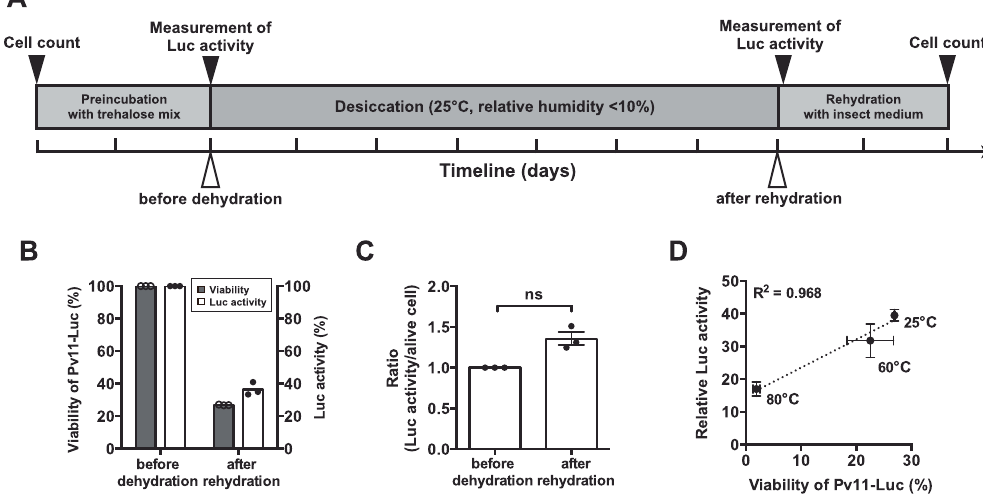
Figure 2. Viability and enzyme activity of Pv11 (Pv11-Luc) cells stably expressing luciferase. ( A) Schematic timeline represents the time point of each treatment (white arrowheads) and of the measurements (black arrowheads), respectively. Major tick intervals represent one day. The detailed procedures including preincubation, desiccation and rehydration are described in the previous study 30 . Pv11 cells are expected to be fully dehydrated about 30 h after the beginning of desiccation. Percentage of luminescence intensity of Luc and cell count was measured before the desiccation step (i.e., after pretreatment with 600 mM trehalose mixture containing both 10% IPL-41 and 1% FBS). Luminescence intensity caused by luciferase was measured 1 h after rehydration. Viability of Pv11-Luc cells was counted with the WST-8 assay. ( B) Viability of Pv11-Luc cells (bars in grey) and percentage of Luc activity (bars in white) are shown as a scatter dot plot (n = 3). Error bar shows standard error of mean. ( C) Luc activity of surviving cells is represented as the ratio of luciferase activity over cell number. The number of surviving cells was estimated using the WST-8 colourimetric determination assay before dehydration and after rehydration. In this assay, “before dehydration” means before preincubation with trehalose mixture, and “after rehydration” means 2 days after rehydration with insect medium. The number of surviving cells was estimated using the calcein staining method after pre-incubation with trehalose and 1 h after rehydration (Fig. S2). Statistical significance was evaluated with Mann-Whitney U test ( p = 0.064). ( D) Heat stress effect. Dry samples were heated for 5 min at 60 and 80 °C before rehydration. The cells treated at 25 °C represent unstressed